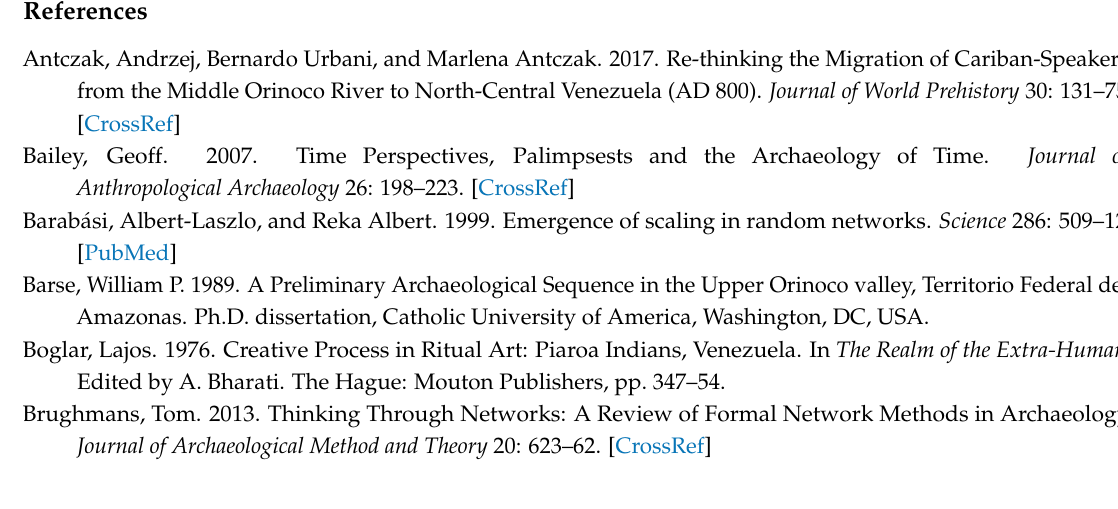
Table S1: rockart_attr_middleorinoco.csv, Table S2: rockart_count_middleorinoco.csv, Code: